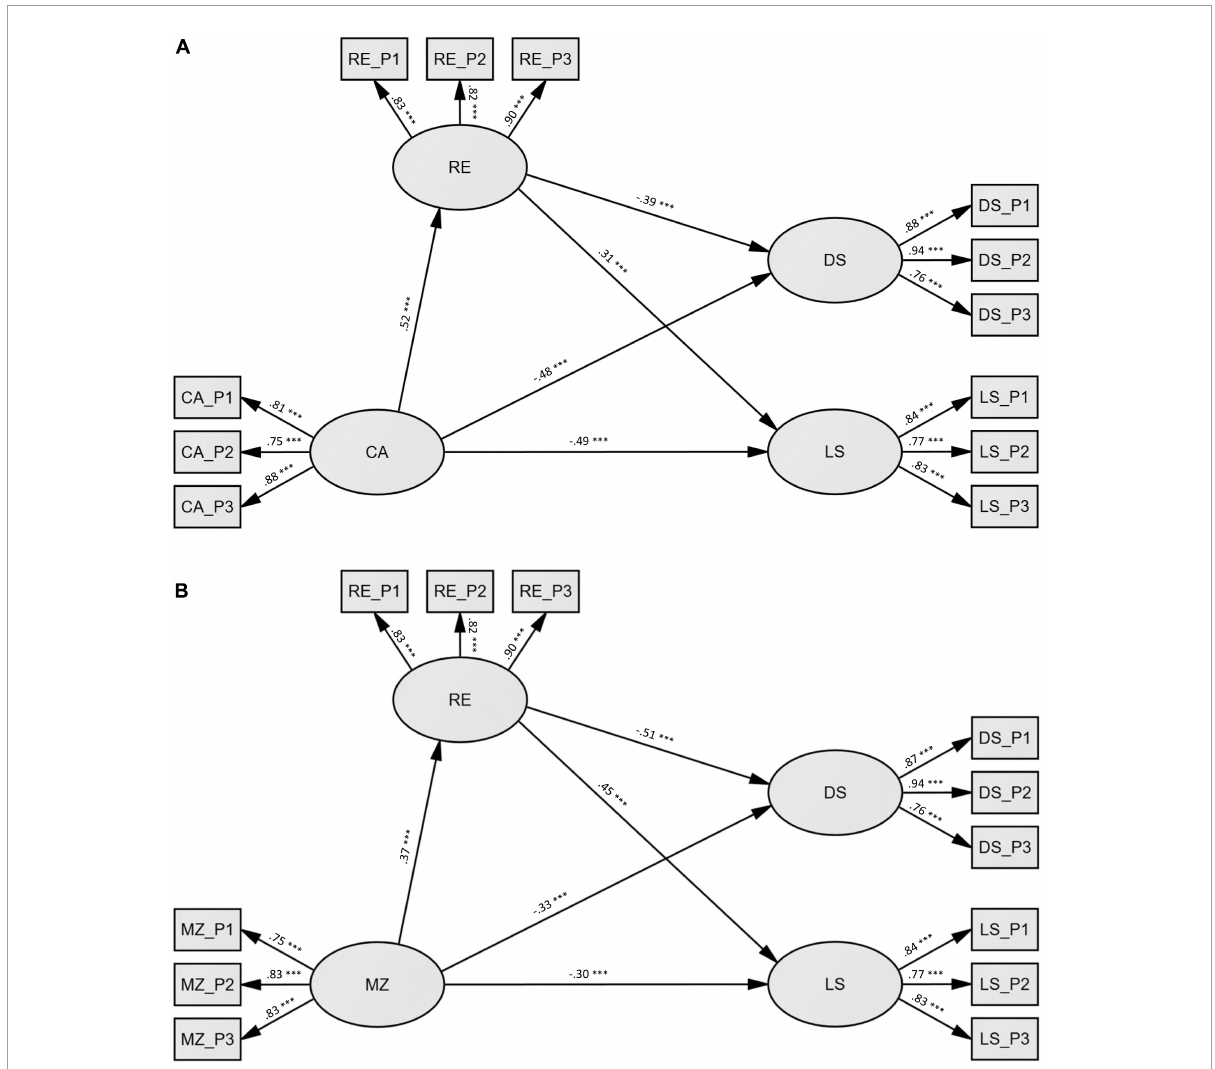
FIGURE2 Illustration of structural models SEM1 and SEM2 ( n = 316). (A) SEM1: independent variable = criterion A (CA), dependent variables = depressive symptoms (DS), and life-satisfaction (LS), mediator = resilience (RE). (B) SEM2: independent variable = mentalization (MZ), dependent variables = depressive symptoms (DS), and life-satisfaction (LS), mediator = resilience (RE). Both models showing standardized regression coefficients β and are controlled for age, gender, and social connectedness. All effects were significant at ∗∗∗ p < 0.001. CA_P1 – CA_P2 = three parcels of criterion A, MZ_P1 – MZ_P2 = three parcels of mentalization, RE_P1 – RE_P2 = three parcels of resilience, DS_P1 – DS_P2 = three parcels of depressive symptoms, LS_P1 – LS_P2 = three parcels of life